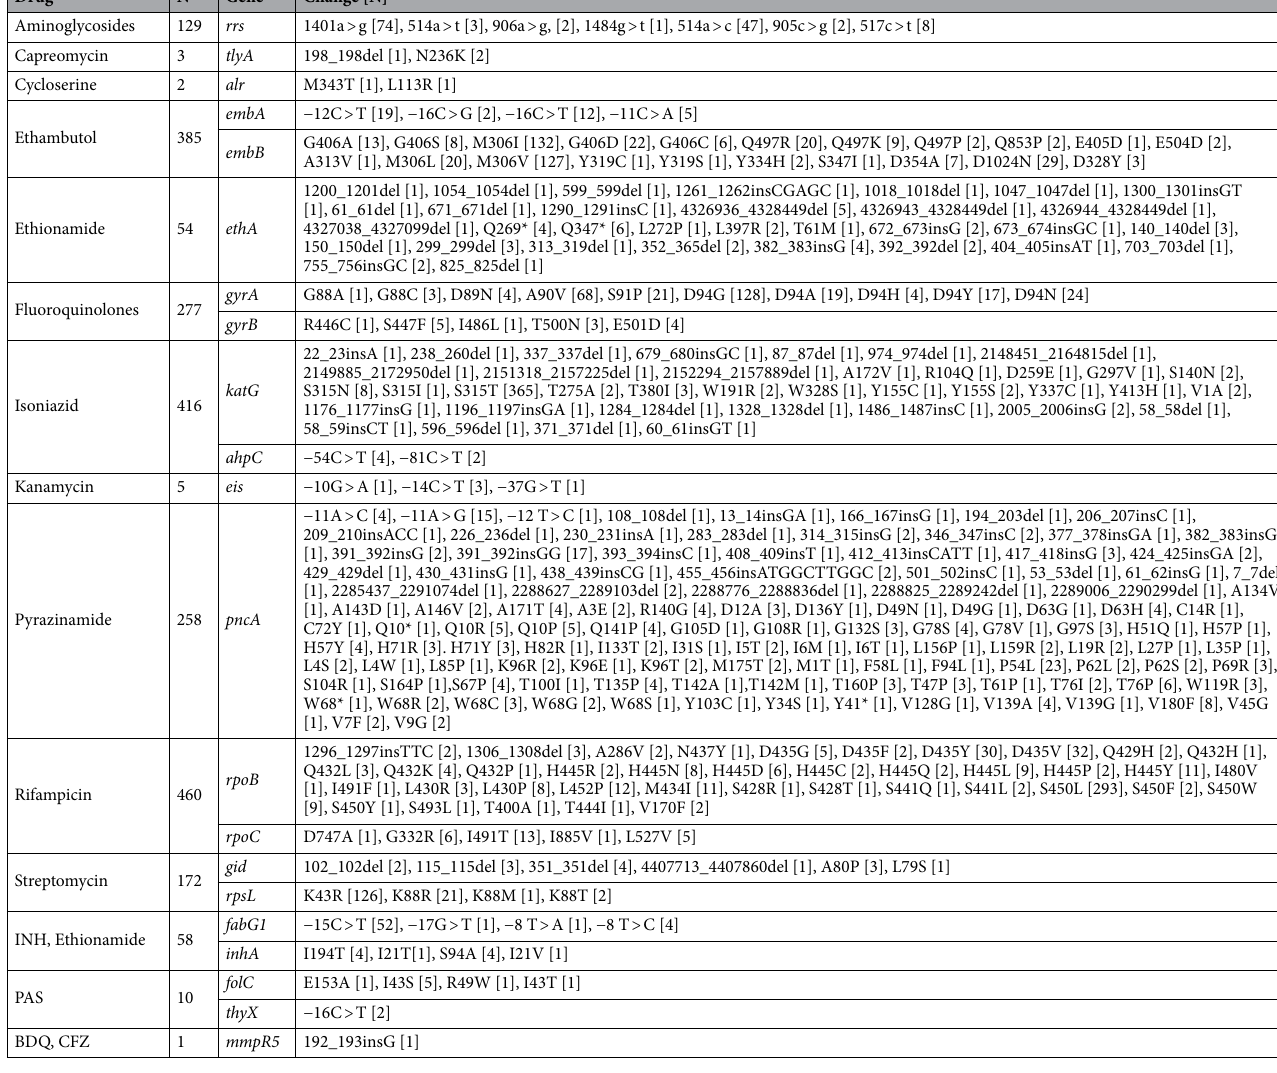
Table 2. Number of samples with known drug resistance-associated mutations. BDQ bedaquiline, CFZ clofazimine, INH isoniazid, PAS para aminosalicylic acid. *Premature stop